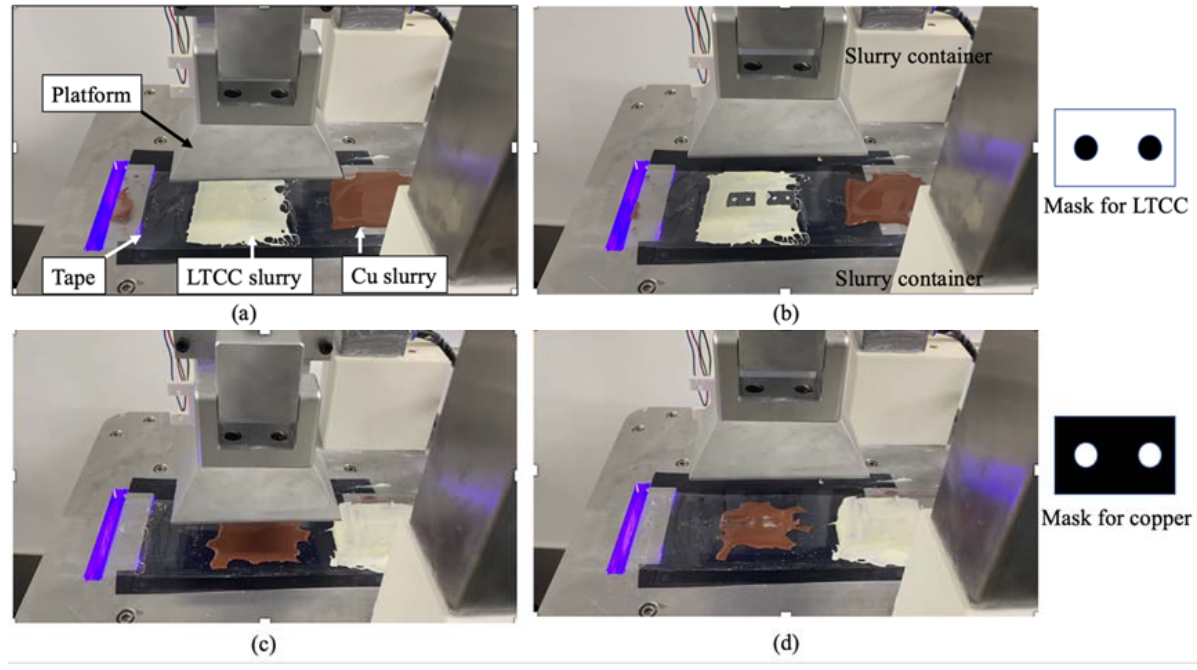
Figure 3. The tape-casting multi-slurry 3D printing process for the assembled printer. ( a ) depositing slurry on the tape; ( b ) photopolymerized LTCC adheres to the platform; ( c ) printing the Copper slurry; ( d ) the completion of copper slurry printing.